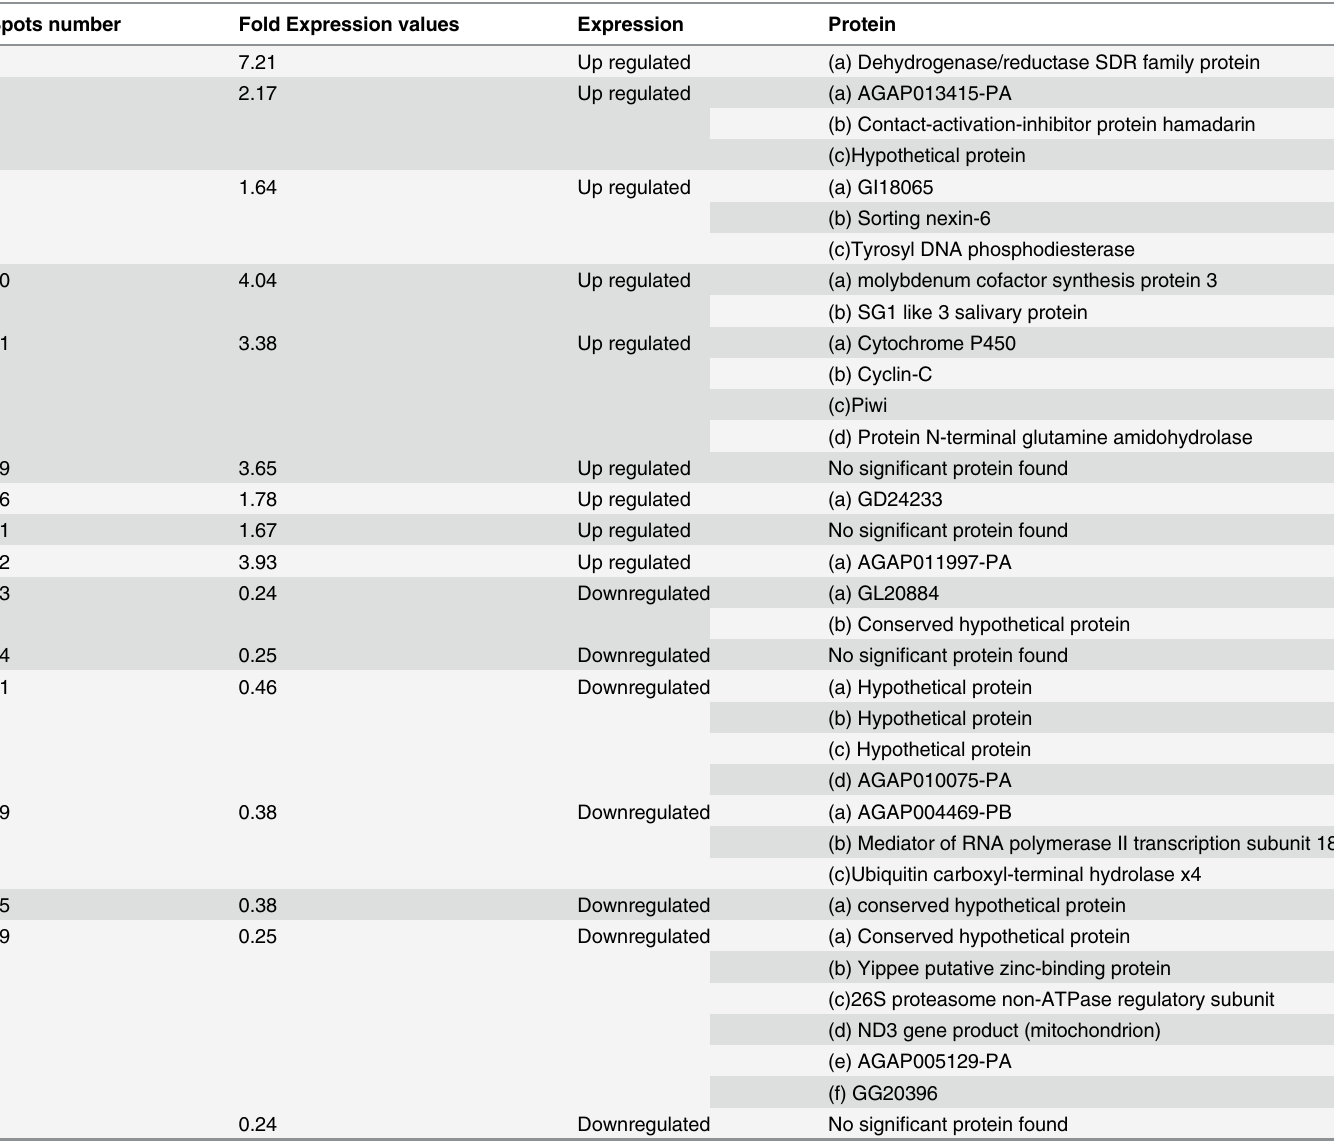
Table 1. Annotated total identi fi ed proteins spots with their fold expression values in An . stephensi multi resistant strain. Spots